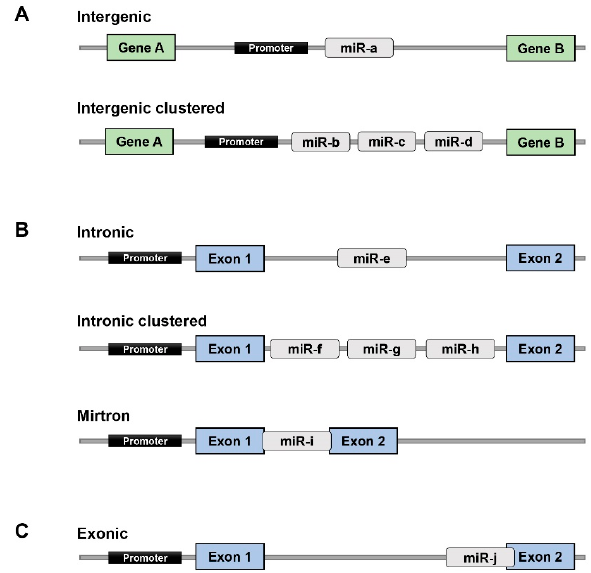
Figure 2. Genomic location of miRNAs. ( A ) Intergenic miRNAs are found in genomic regions between genes. They may be present as a single miRNA (miR) gene or a cluster of miRNA genes; ( B ) Intronic miRNAs are found in the introns of annotated genes. Like intergenic miRNAs, intronic miRNAs may exist in the single or clustered format and can also overlap with exons; ( C ) Exonic miRNAs often span across an exon and an intron of a noncoding gene.